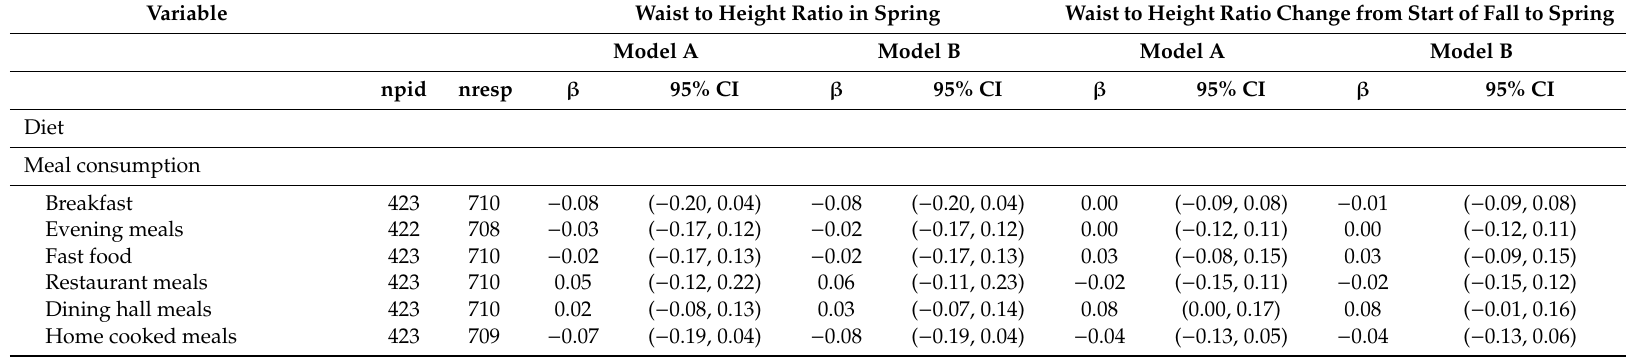
Table 7. Results of the longitudinal linear mixed e ff ect models examining if students’ survey responses on weight-related behavioral factors were associated with their waist to height ratio, or waist to height ratio change B